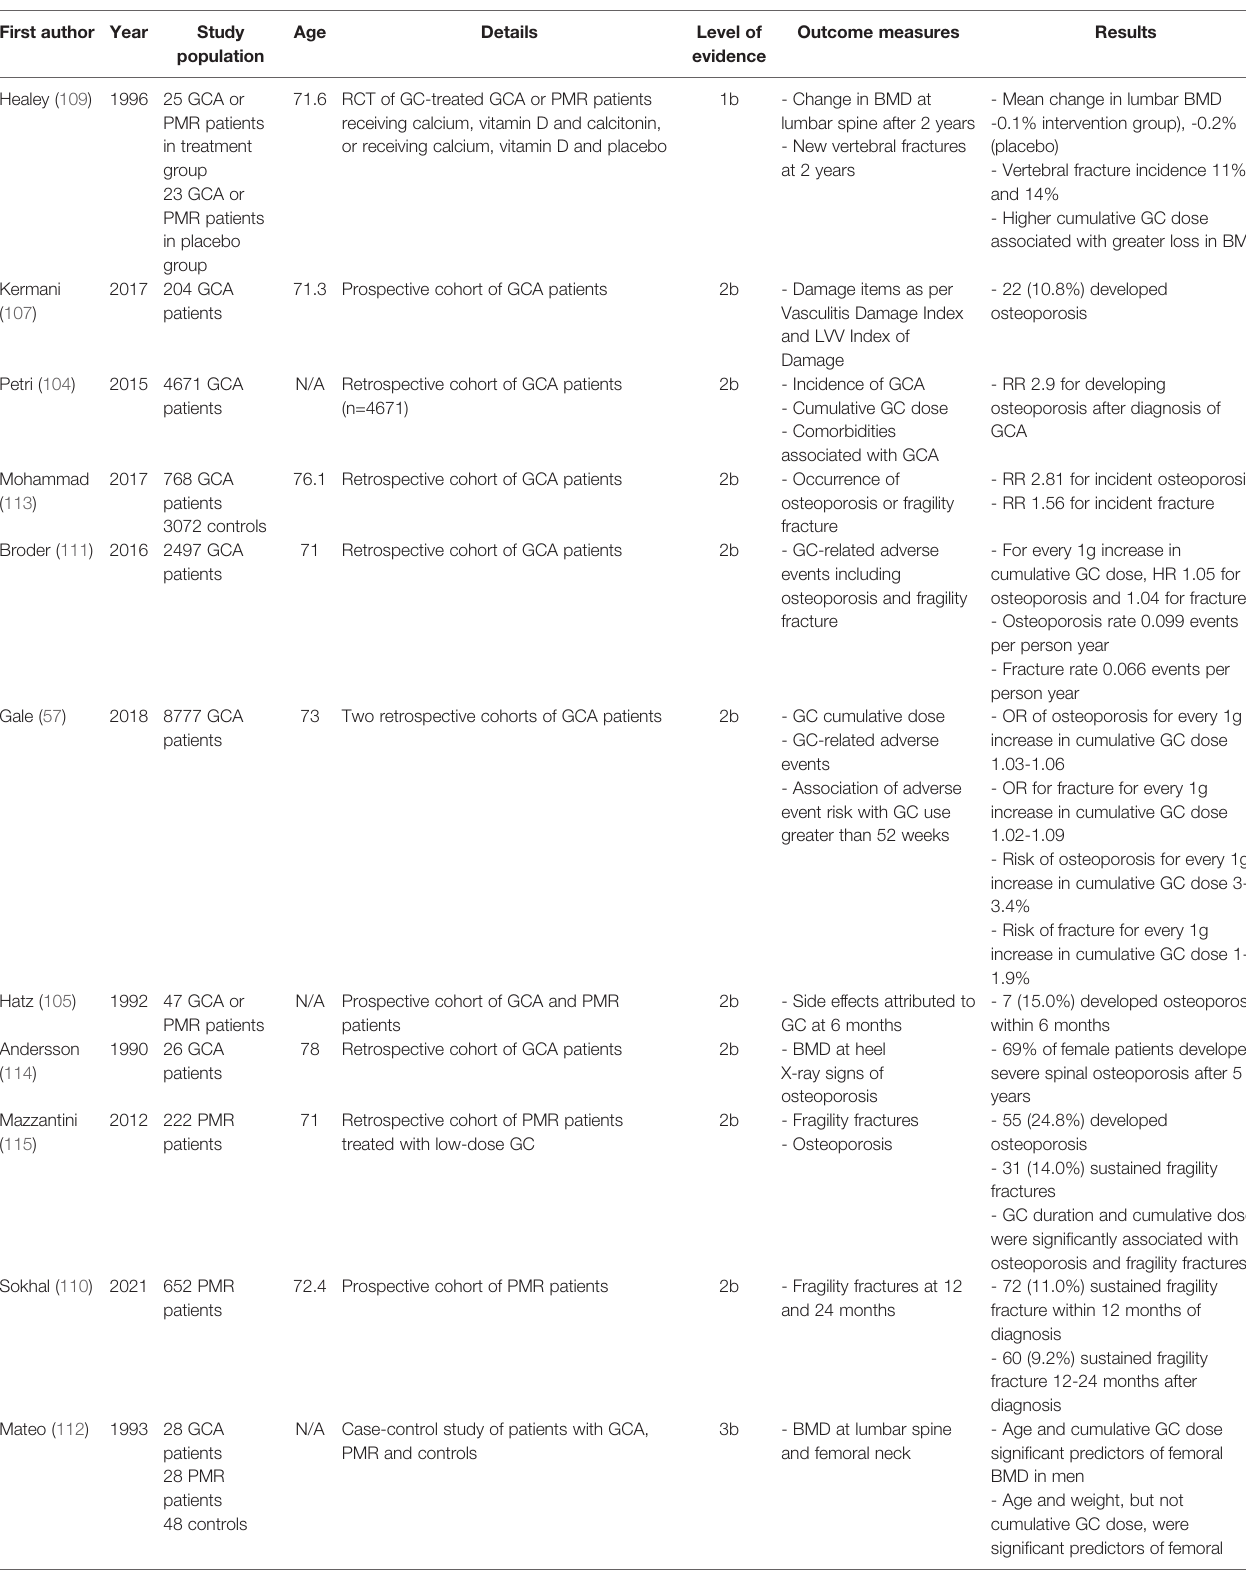
TABLE 1 | Summary of studies on osteoporosis and fracture risk in Giant Cell Arteritis (GCA) and Polymyalgia Rheumatica